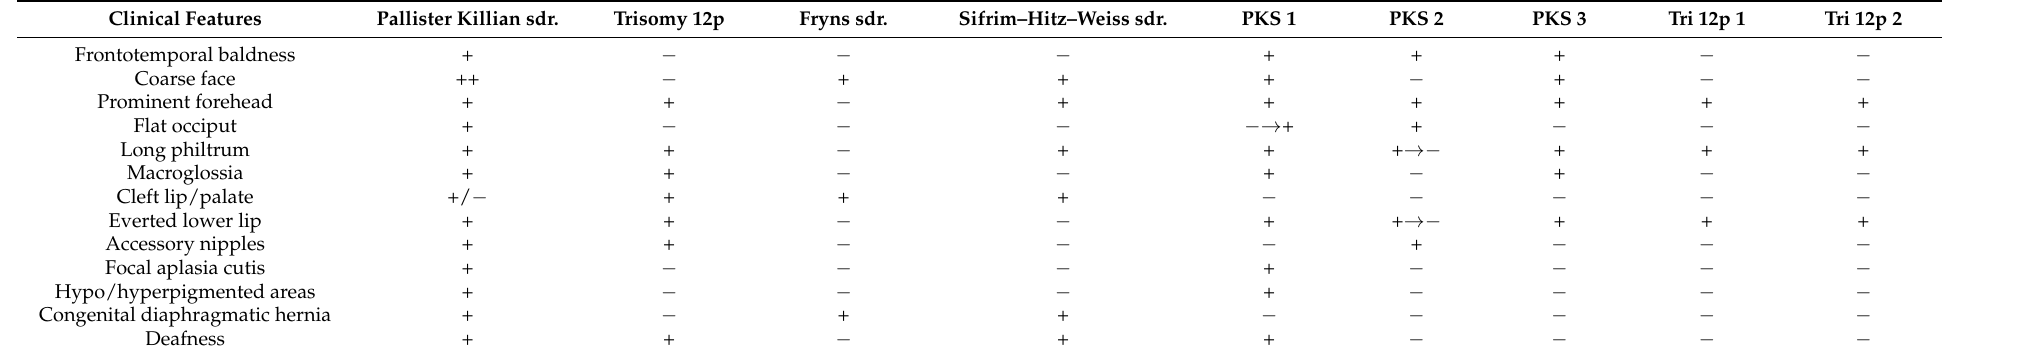
Table 1. Literature data (columns 2–4 for differential diagnosis) and patient data (columns